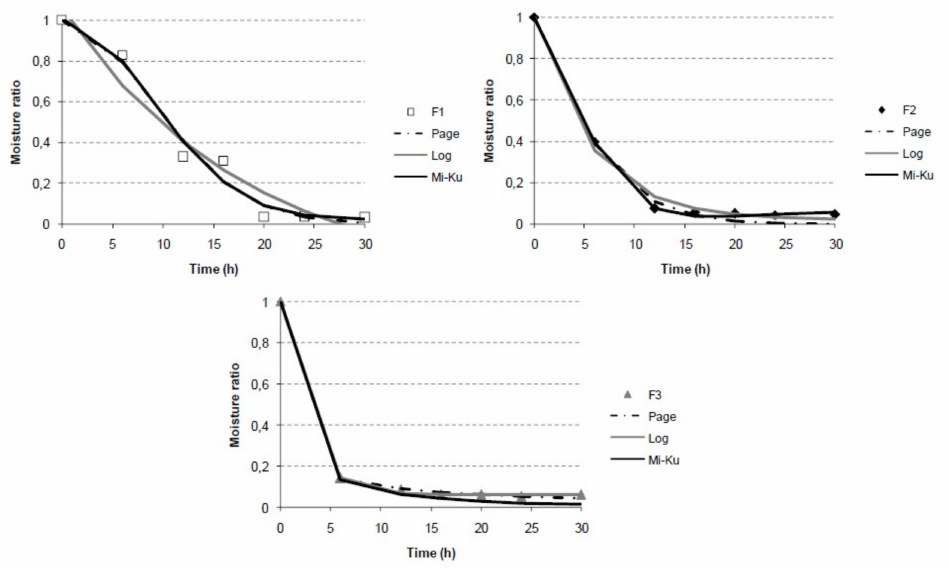
Figure 1. Experimental and modeled freeze-drying curves (Page, logarithmic, and Midilli-Kucuk models) for grapefruit formulations (F1, F2, and